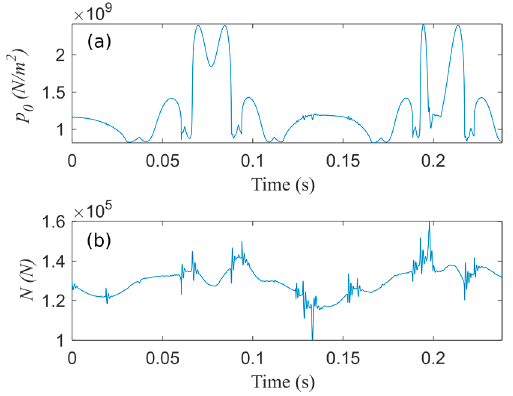
Figure 7. ( a ) Maximum pressure distribution between wheel and rail, ( b ) normal force. The results of the Simpack simulation are the forces 𝑁 , 𝑇 (cid:2935) and 𝑇 (cid:2934) . The 𝑁 , 𝑇 (cid:2935) forces are transformed into the orthogonal forces 𝑌 and 𝑄 , respectively, which are taken as the input forces for the rail model. According to the wheel position on the track, the overall forces are rotated and aligned from the reference frame xy’z’ to the reference system xyz, see Figure 5; thus: